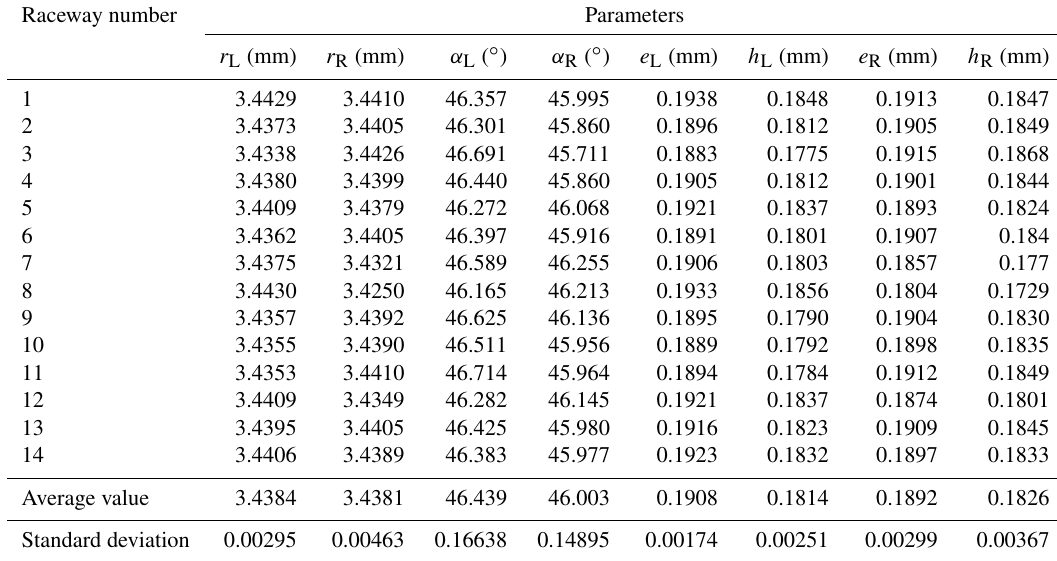
Table 1. Measurement results of the tested ball screw.